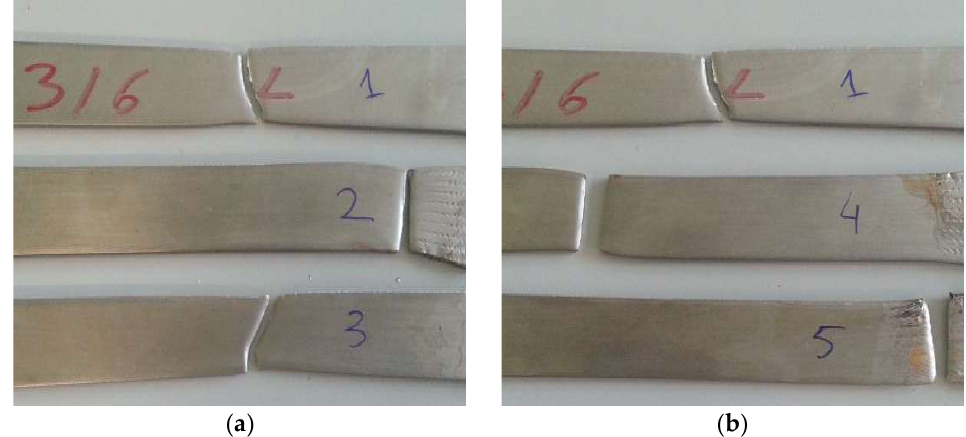
Figure 9. AISI 316L samples at three weeks ( a ) and three months ( b ) following the tensile test. After three weeks (a), the standard specimen and the one immersed in 100% NaClO ruptured approximately in the same zone, in the center, while the specimen immersed in 5% NaClO ruptured near the clamping area of the clamps of the testing machine. On the